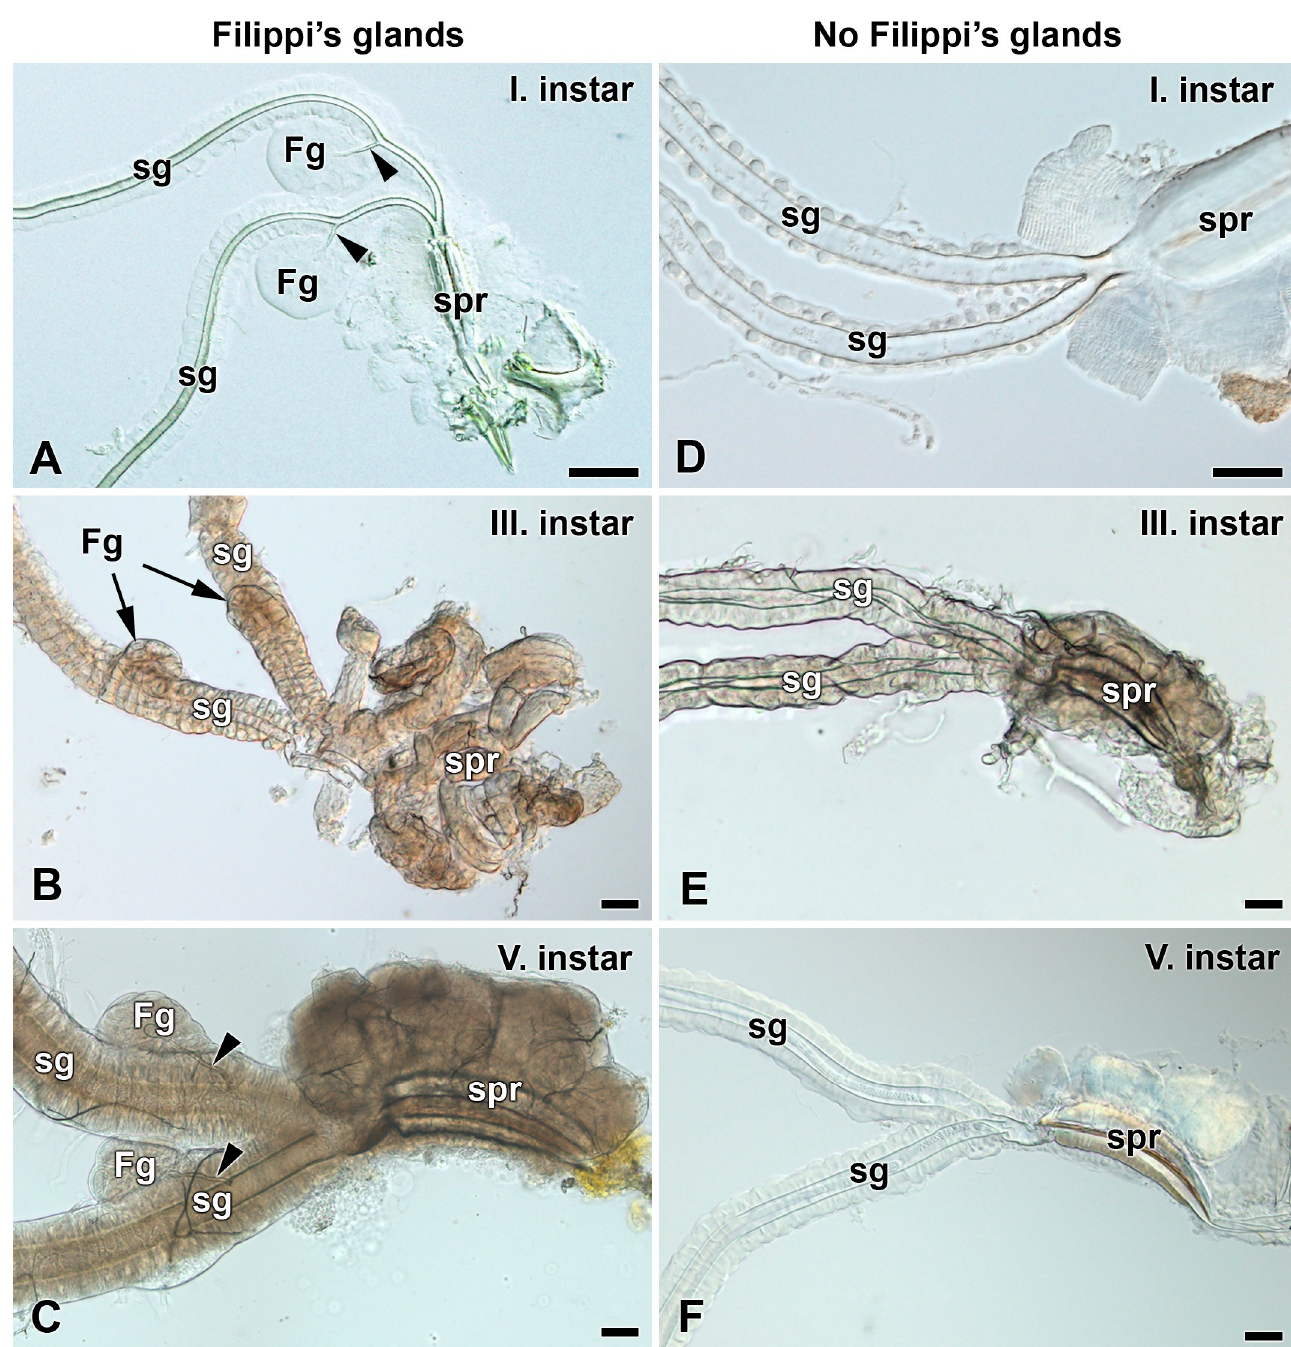
Figure 5. Development of spinning apparatuses of two representative species of hawk moth larvae (Sphingidae), first, third, and fifth instars. ( A – C ) Brightfield microscopy images of the spinning apparatus of the oleander hawk moth, Daphnis nerii . The arrowheads indicate the ducts of the FGs entering the lumen of the SGs. The arrows depict the FGs. ( D – F ) The spinning apparatus of the lime hawk moth, Mimas tiliae . Note that the FGs are completely missing through the entire larval development. Abbreviations: Filippi’s gland (Fg), silk (labial) gland (sg), and silk press of the spinning apparatus (spr). Scale bars: 50 μ m.